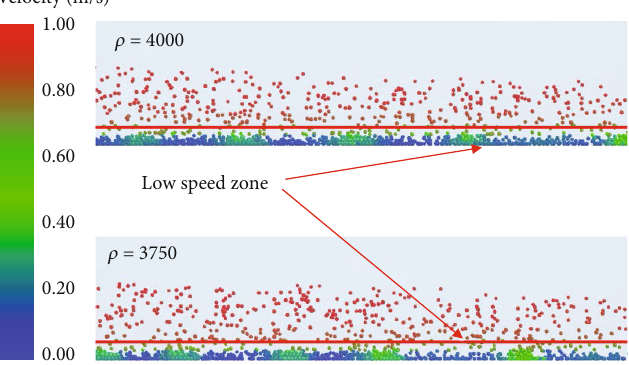
Figure 8: Cloud map of local velocity of single